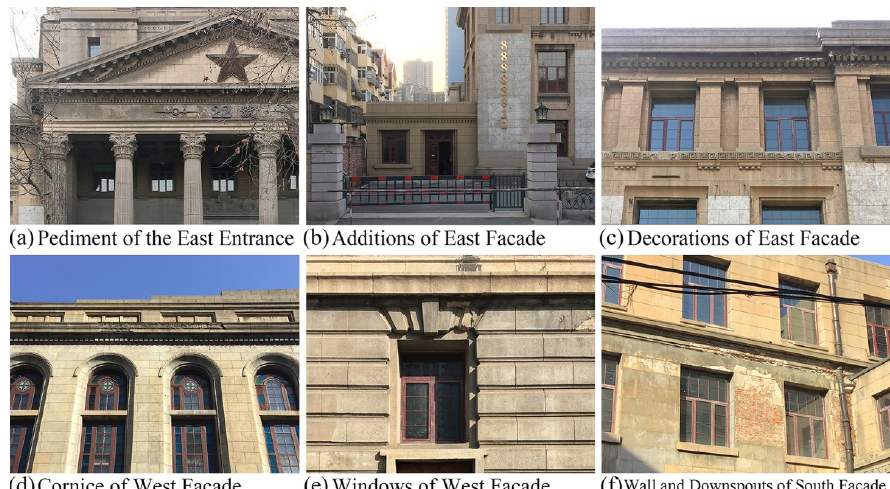
Figure 12. East Facade of Qingdao Exchange